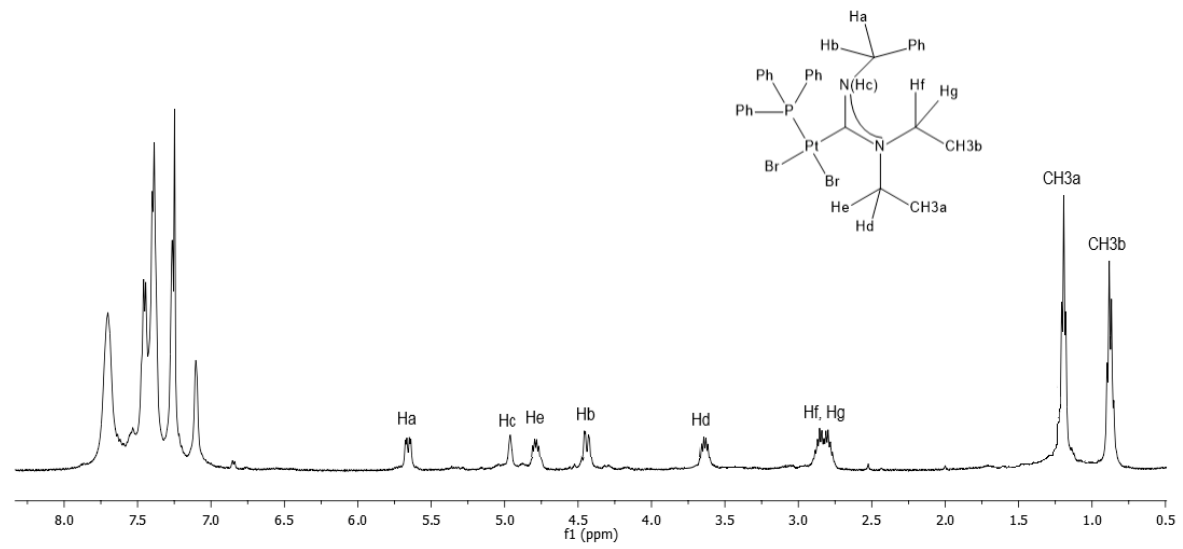
Figure 2. 1 H NMR spectrum (CDCl 3 ) of complex 5 .